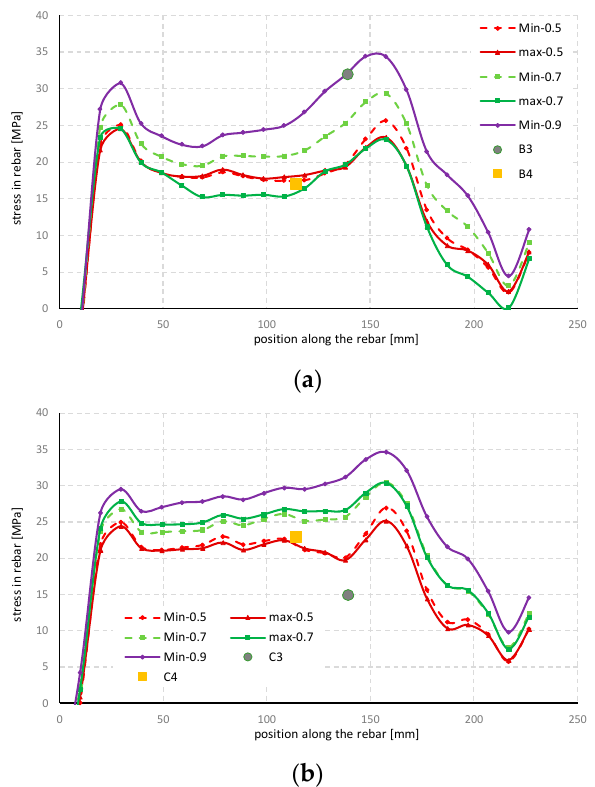
Figure 15. Comparison of numerical and experimental stresses in the rebars in the bottom flange: ( a ) Gauges B; ( b ) Gauges C.